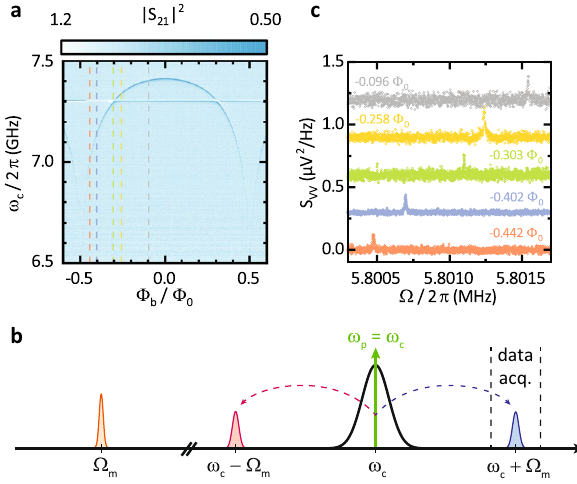
Figure 2. Characterization of the electromechanical circuit. ( a ) Calibrated microwave transmission magnitude as a function of the normalized applied magnetic flux. The flux-dependent inductance of the circuit allows for the adjustment of the resonance frequency from 7.45 to 6.6 GHz. A parasitic resonance is visible around 7.3 GHz. Colored dashed reference lines correspond to the flux bias points at which the mechanical resonance frequency is analyzed in detail. ( b ) Overview of the relevant frequencies and microwave tones used in the measurement. For the determination of the mechanical resonance frequency (cid:31) m we perform spectral analysis of the anti-Stokes field. ( c ) Voltage power spectral density of the demodulated probe tone, analyzed around its anti- Stokes peak at various flux bias points (see labels next to the data trace) for a fixed in-plane field of B IP = 35 mT . 2 / Hz The spectra are offset by 0.3 µ V each for clarity. The Lorentz-shaped mechanical resonance features shift to higher frequencies by roughly 1 kHz as the normalized flux bias is